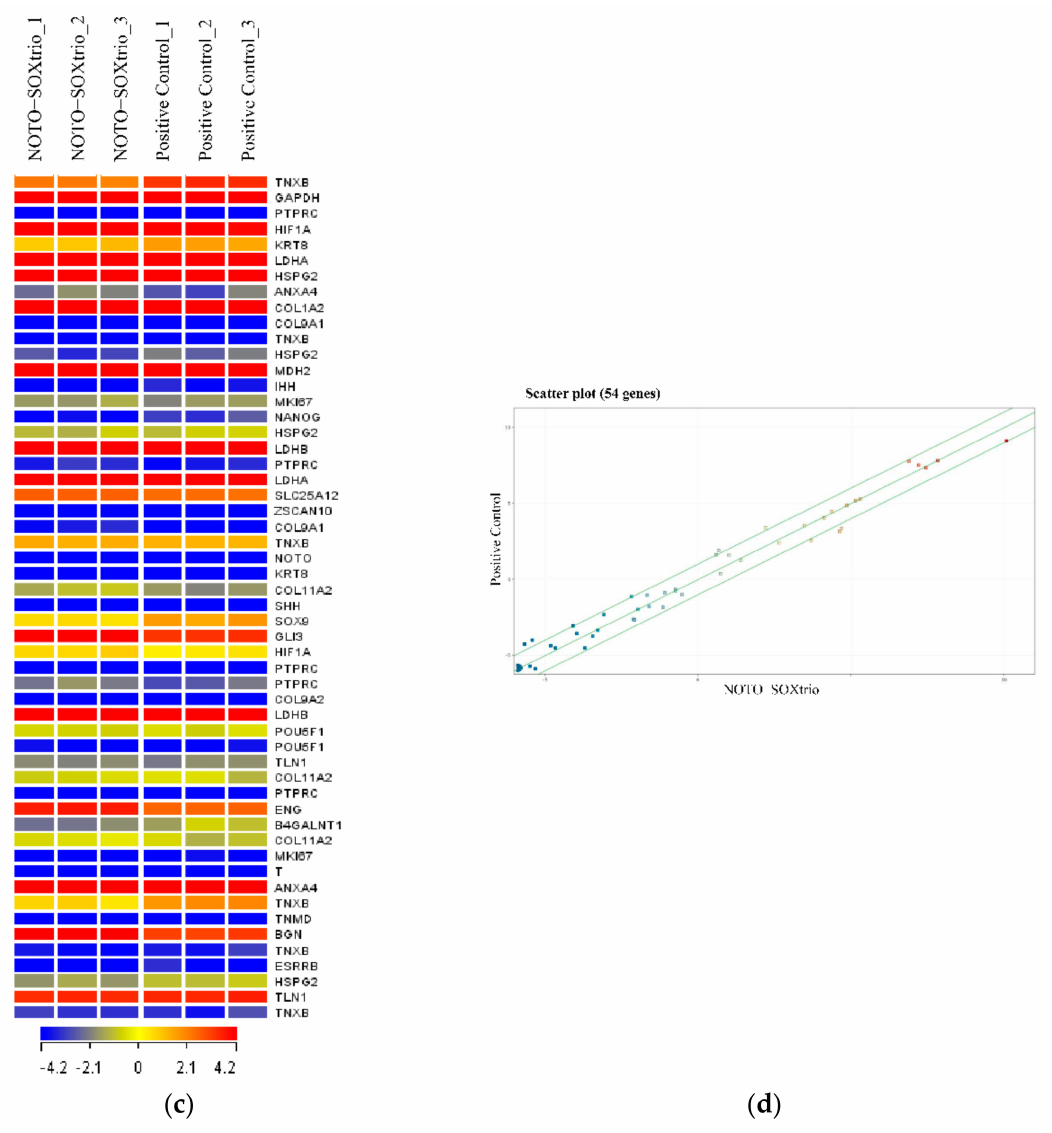
Figure 5. Microarray analysis of genes expressed by NHDFs: ( a ) The heatmap of the genes filtrated by flags (22,425 genes) was shown. All groups showed mean expression levels (each group; n = 3). ( b ) Scatter plot analysis. The lower panels show the number of genes with expression levels differing 2-fold compared with the positive control (NP) and the NOTO-SOXtrio group. ( c ) Heatmap of NP-specific genes (Positive control, n = 3; NOTO-SOXtrio, n = 3). ( d ) Scatter plot of NP-specific genes (n =